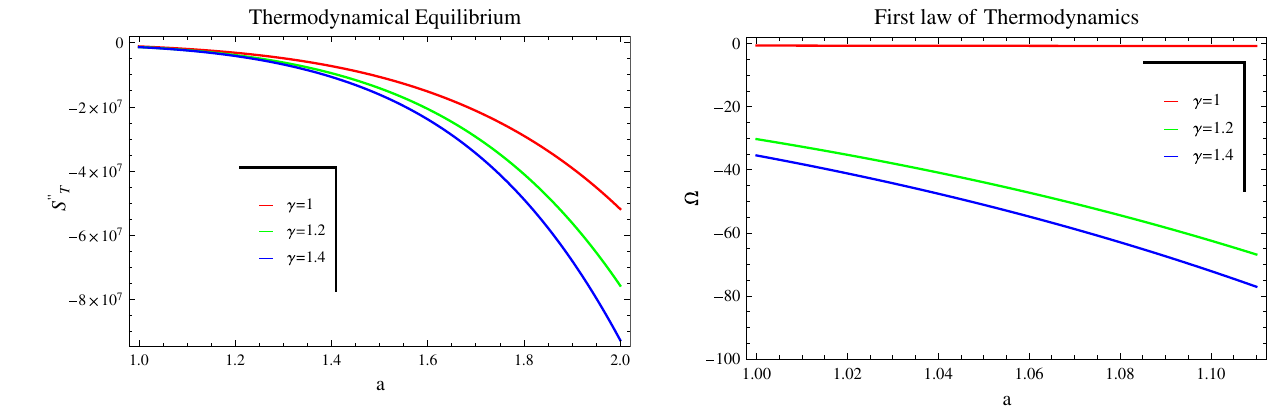
Fig. 9 Plot of S (cid:7)(cid:7) versus a for power law corrected entropy using k = T 1 , λ = − 1 , α = 1 , L p = 1 , r c = 1 and b = 1 67